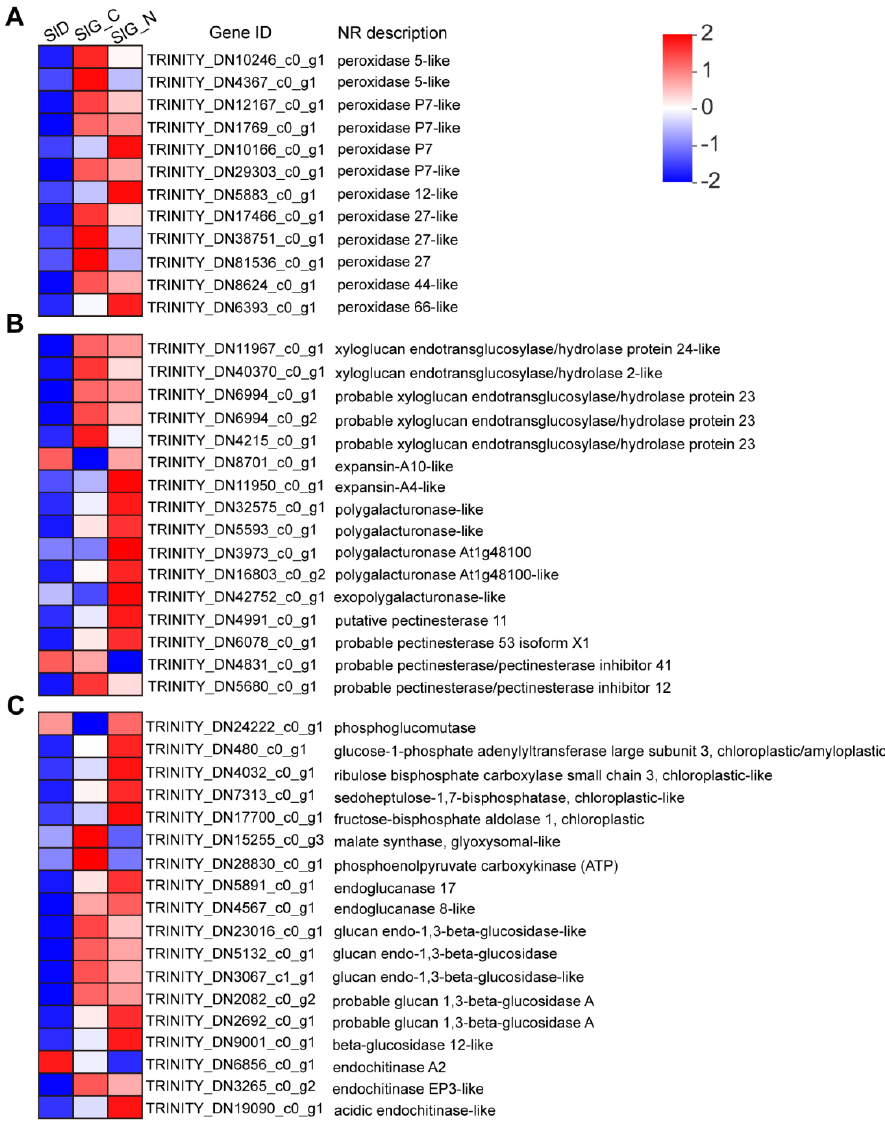
Figure 6. Heatmap of differential expression genes related to the reactive oxygen species metabolic process ( A ), cell wall organization or biogenesis ( B ), and carbohydrate metabolic process ( C ) in SlD, SlG_C, and SlG_N. The values of the blue to red gradient bar indicate the log 10 fold change in expression.